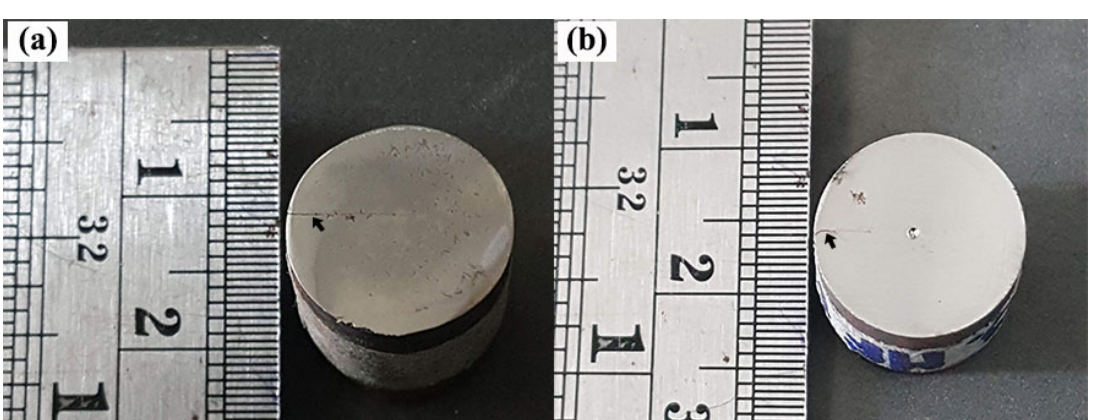
Figure 6. Macro-crack morphology of specimen quenched in (a) regular tap water, and (b) magnetically treated tap water.